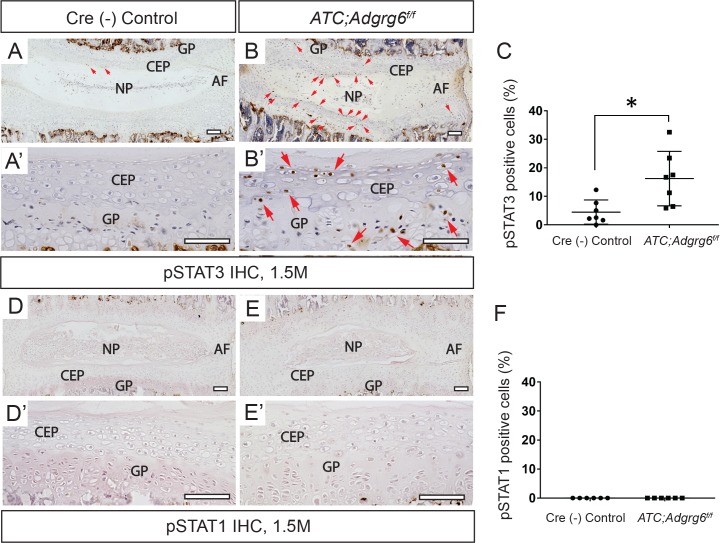
ADGRG6 regulates STAT3 signaling in IVDs.(A-B’) IHC analysis shows increased expression of pSTAT3 (red arrowheads, B, B’) in ATC;Adgrg6f/f mutant mouse IVD at 1.5 months (induced from E0.5-P20, n = 3 for each group.) (D-E’) IHC analysis shows no signal of pSTAT1 in neither Cre(-) nor ATC;Adgrg6f/f mutant mouse IVD at 1.5 months (induced from E0.5-P20, n = 3 for each group.) (C, F) Quantification of positive pSTAT3 (C) and pSTAT1 (F) cells in Cre(-) control or in ATC;Adgrgf/f mutant mouse IVDs. (n = 3 mice for each group, at least two IVDs were scored for each mouse. Dots plot with mean ± SD. *p≤0.05, two-tailed Student's t Test.) Scale bars: 200μm in (A, B), and 50μm in (A’, B’). CEP- cartilaginous endplate, GP- growth plate, and NP- nucleus pulposus.